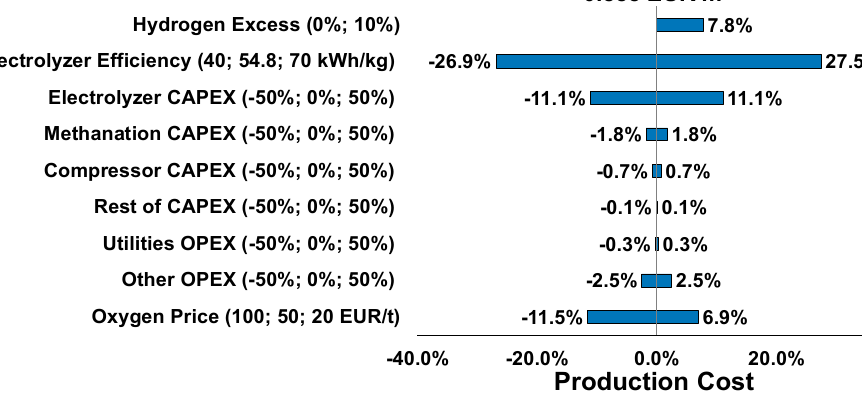
Figure 11. Sensitivity analysis of different cost components of the NG case.